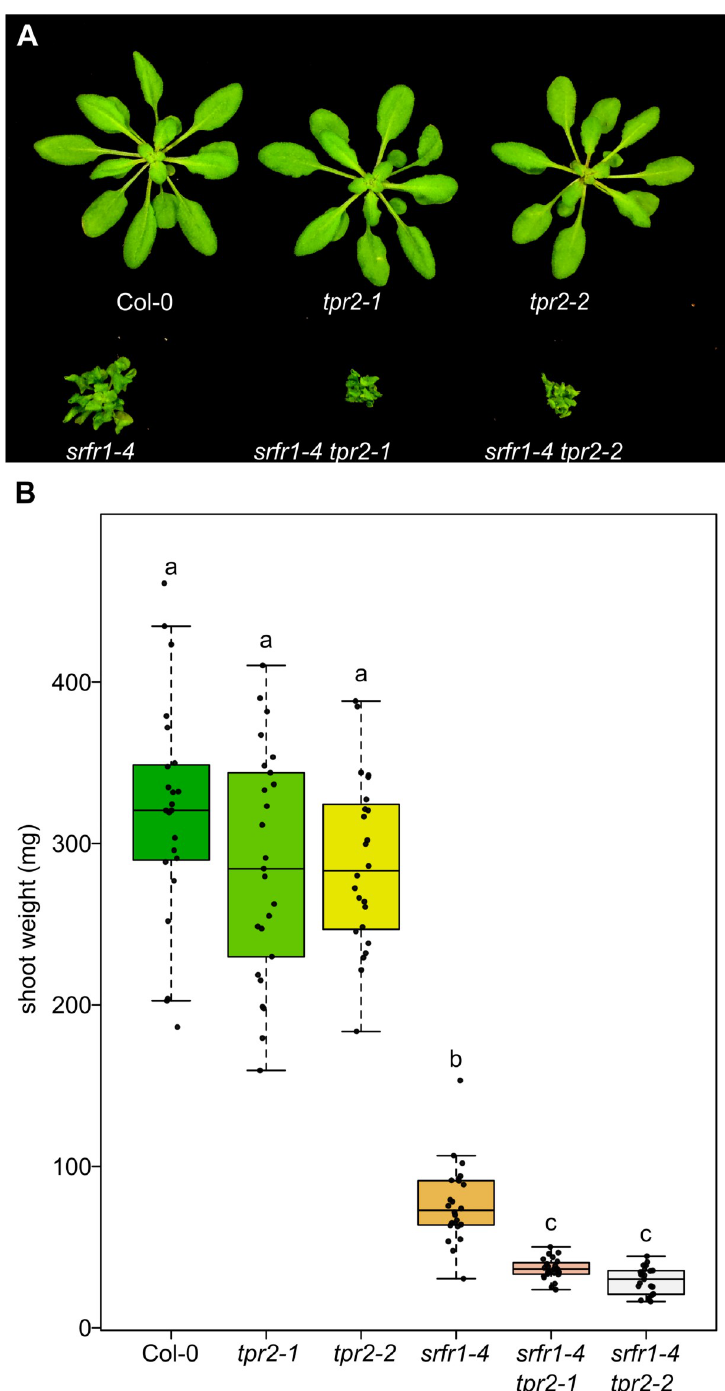
Fig 2. Multiple alleles of TPR2 increase stunting in srfr1 . (A) Morphological phenotypes of tpr2-1 , tpr2-2 , srfr1-4 , srfr1-4 tpr2-1 , and srfr1-4 tpr2-2 at four weeks post sowing. (B) Shoot weight from plants grown under short day conditions at 21˚C for four weeks. Dots represent individual data points. Whiskers on boxplots are drawn to the farthest data point within 1.5 � IQR of first and third quartiles. Letters denote significant differences as determined by Student’s t-test ( P < 0.05) using the Bonferroni-Holm method to correct for multiple comparisons.